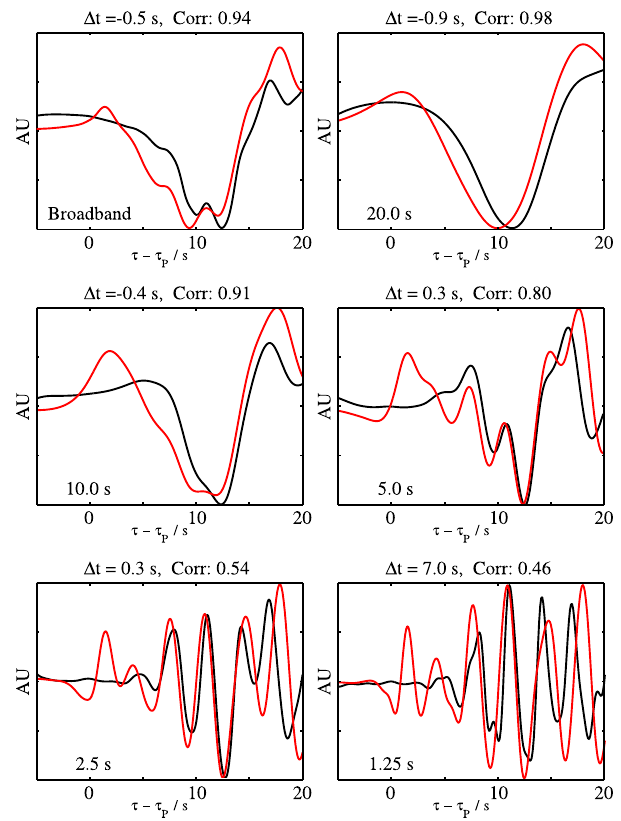
Fig. 8. The fit between a triplicated P-wave and its synthetic, filtered into frequency pass bands. The epicentral distance is 18.6 ◦ , so that Fig. 4. The fit between a triplicated P -wave and its synthetic, fil- the waveform contains triplications from both the 410 and 660 dis- tered into frequency passbands. The epicentral distance is 18.6 ◦ , so continuities. This example uses the same broadband waveforms as that the waveform contains triplications from both the 410 and 660 seen in Fig. 3; the seismic station is VALT (Mount St. Helens crater discontinuities. This example uses the same broadband waveforms as seen in Fig. 3; the seismic station is VALT.